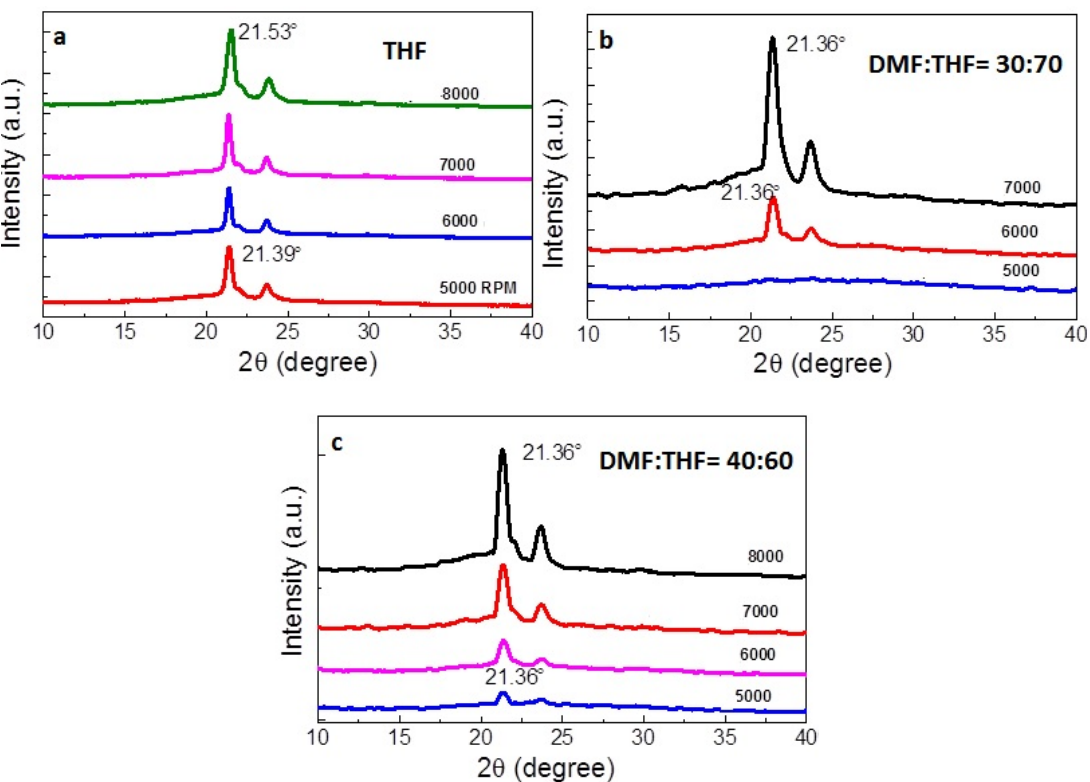
Figure 10. XRD patterns of PCL fibers obtained by FS at different rotational speeds and concentration of PCL solutions, and different solvent mixtures: ( a ) 100% THF solvent; ( b ) 30:70 solvent ratio of DMF:THF; ( c ) 40:60 solvent ratio of DMF:THF.